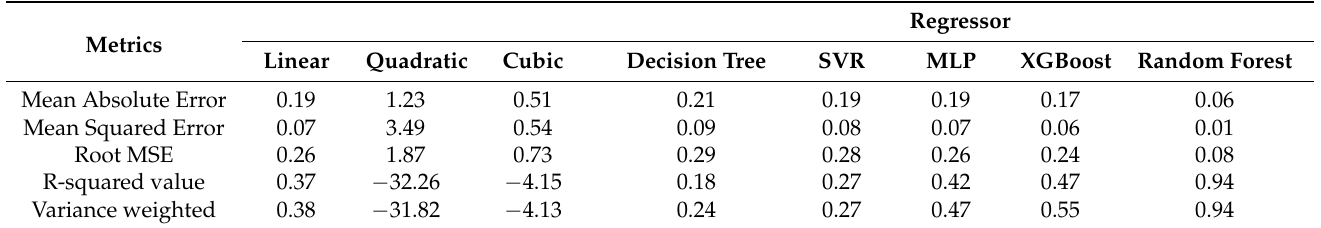
Table 1. Summary of model performances. All values shown are for the test